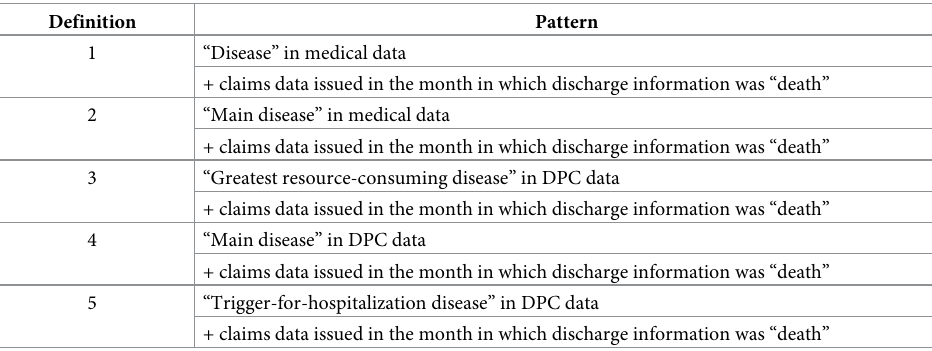
Table 1. Definitions of causes of